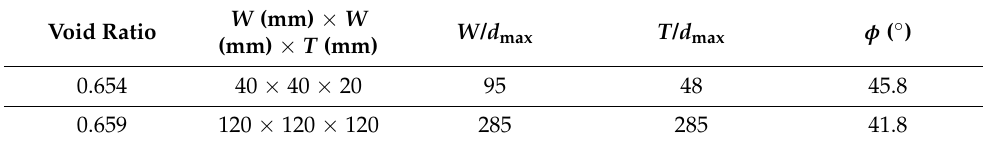
Table 5. Friction angles of the sand samples obtained by Wu et al. [30].